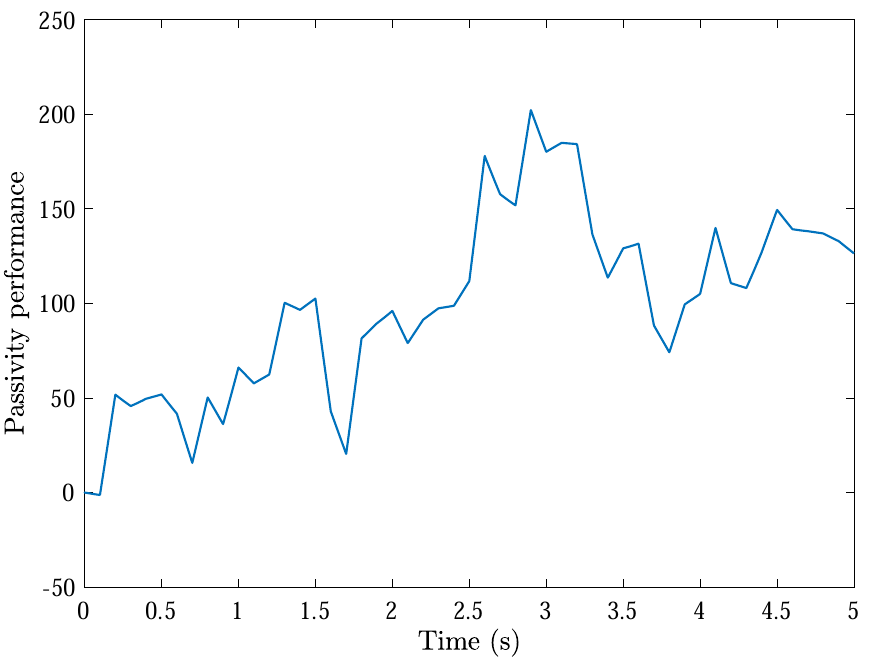
Figure 8. Finite-time passivity